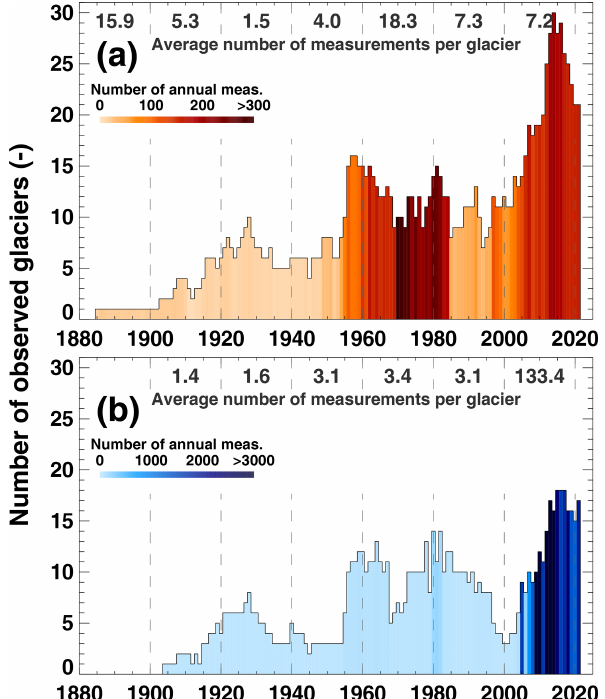
Figure 5. Number of observed glaciers over (a) the annual and (b) the winter period. The shading indicates the total number of conducted point measurements per year and a 2-decadal average of point observations per glacier and year is given on top of each panel